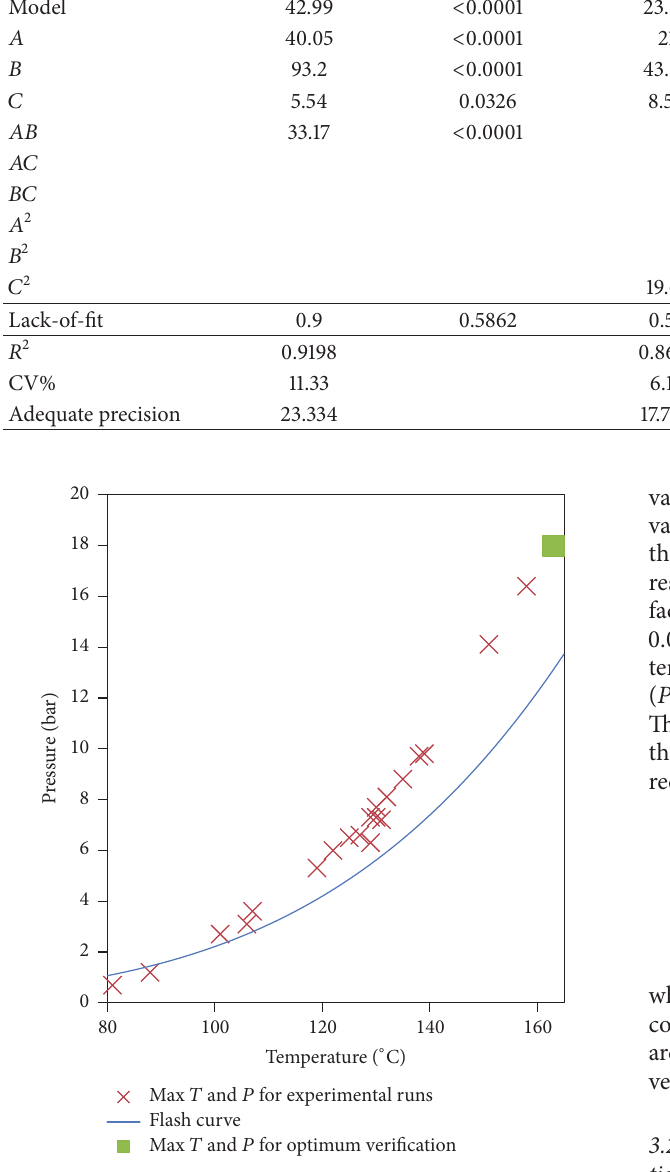
Figure 1: The comparison of maximum temperature and pressure achieved in all experimental and verification runs to the flash curve of ethanol-water mixture without vapor